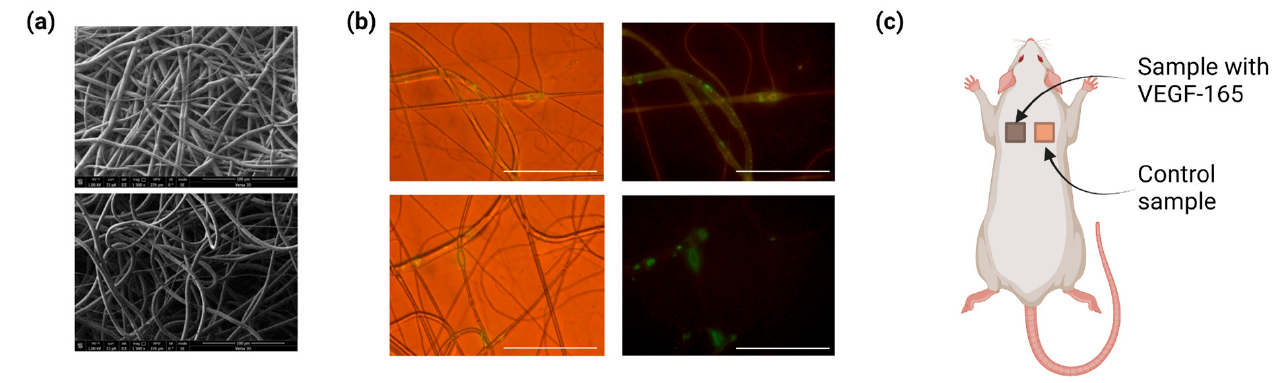
Figure 1. ( a ) Microfibers with incorporated biomolecule-containing buffer, SEM and ( b ) emulsion electrospray-derived microfibers with GFP incorporated: light and fluorescence microscopy. Figure adapted from Tenchurin et al. (2017) with permission of the publisher [33]. ( c ) Surgery scheme for implantation of microfibrous PCL-based scaffolds. Created with BioRender.com.